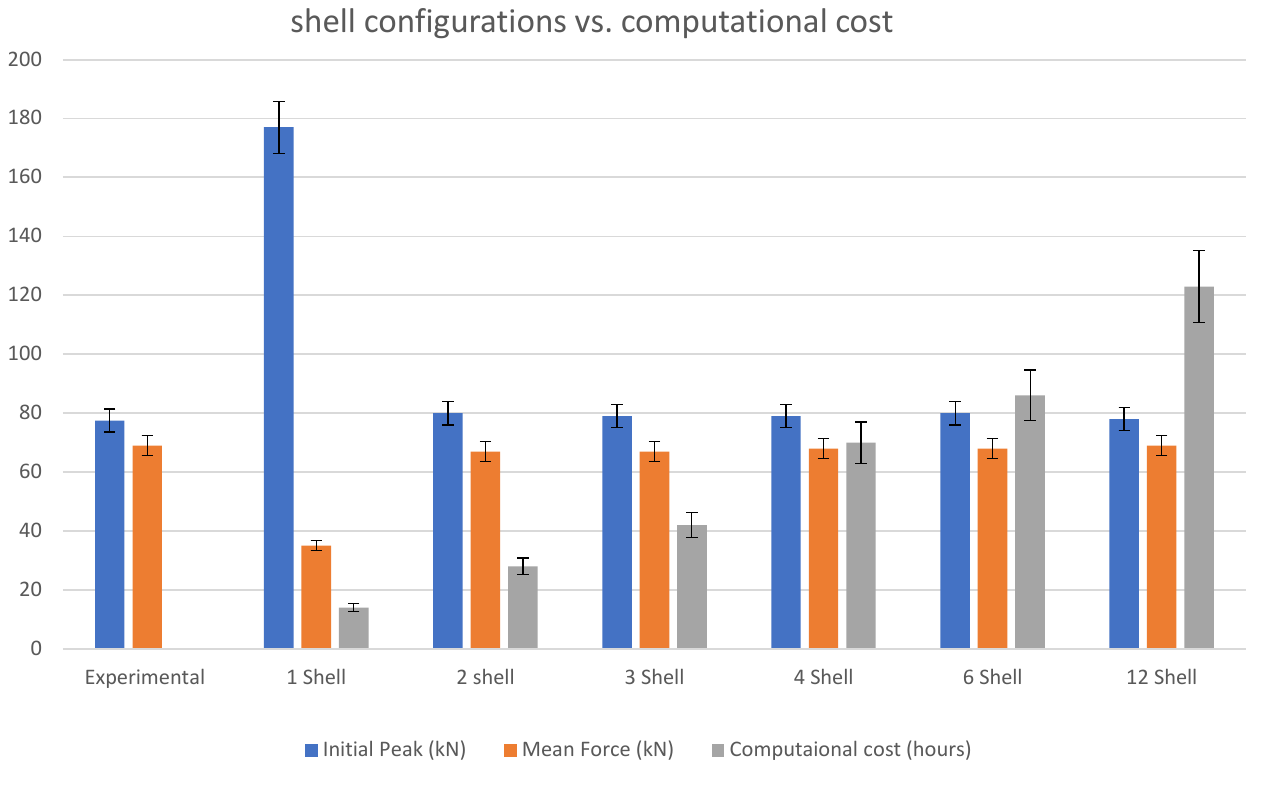
Figure 12. Shell configuration comparison [65].